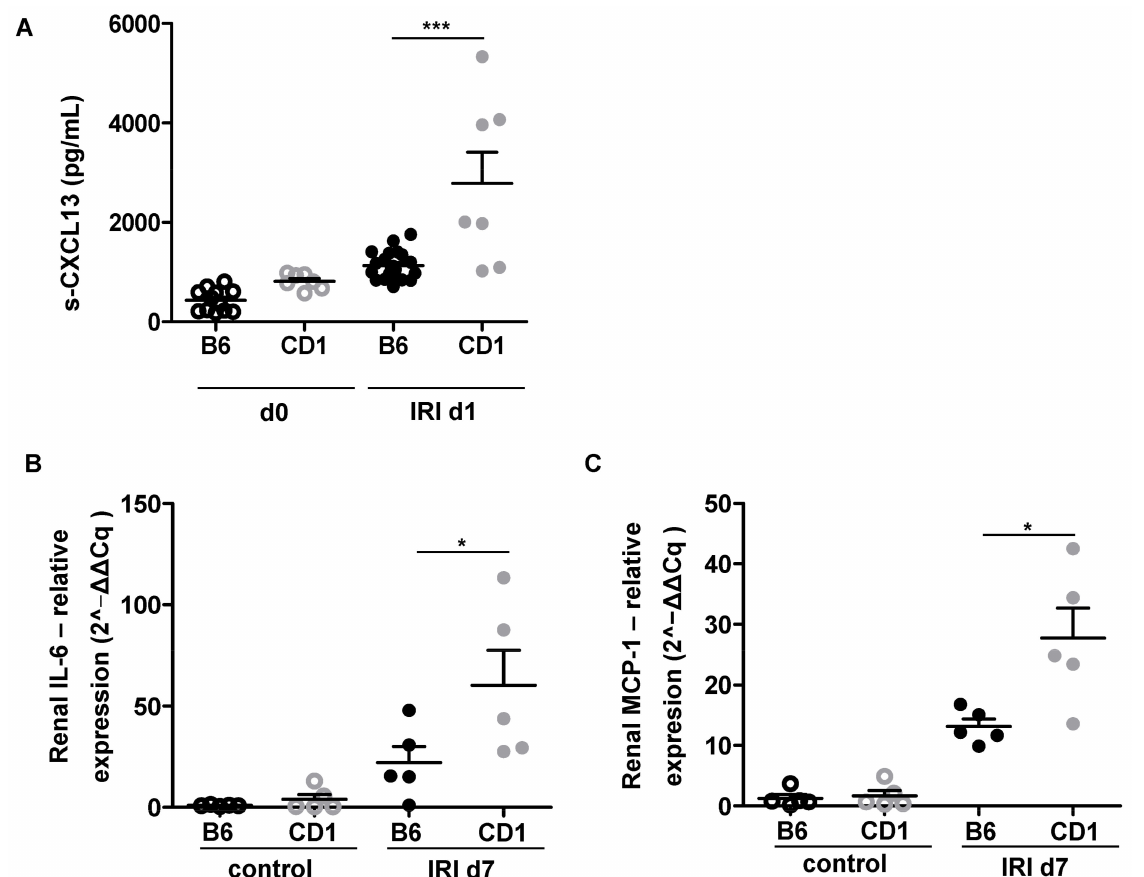
Figure 5. Renal inflammation was aggravated in CD1 after IRI. CD1 (grey dots) exhibits increased systemic upregulation of the B-cell chemoattractant CXCL13 on d1 after IRI compared to B6 (black dots) ( A ). Levels of the pro-inflammatory cytokines IL-6 ( B ) and MCP-1 ( C ) in the renal tissue were quantified by qPCR. Results were processed using the ∆∆ Cq method. CD-1 had significantly higher IL-6 ( B ) and MCP-1 levels ( C ) at d7 following renal IRI. CXCL13 ELISA was performed in n = 7 CD1 and n = 12–21 B6 mice from three independent experiments. qPCR was performed in n = 5 mice from each group. One-way Anova followed by Tukey’s post-hoc test was used for multiple comparison of the normally distributed data. * = p < 0.05 *** = p <